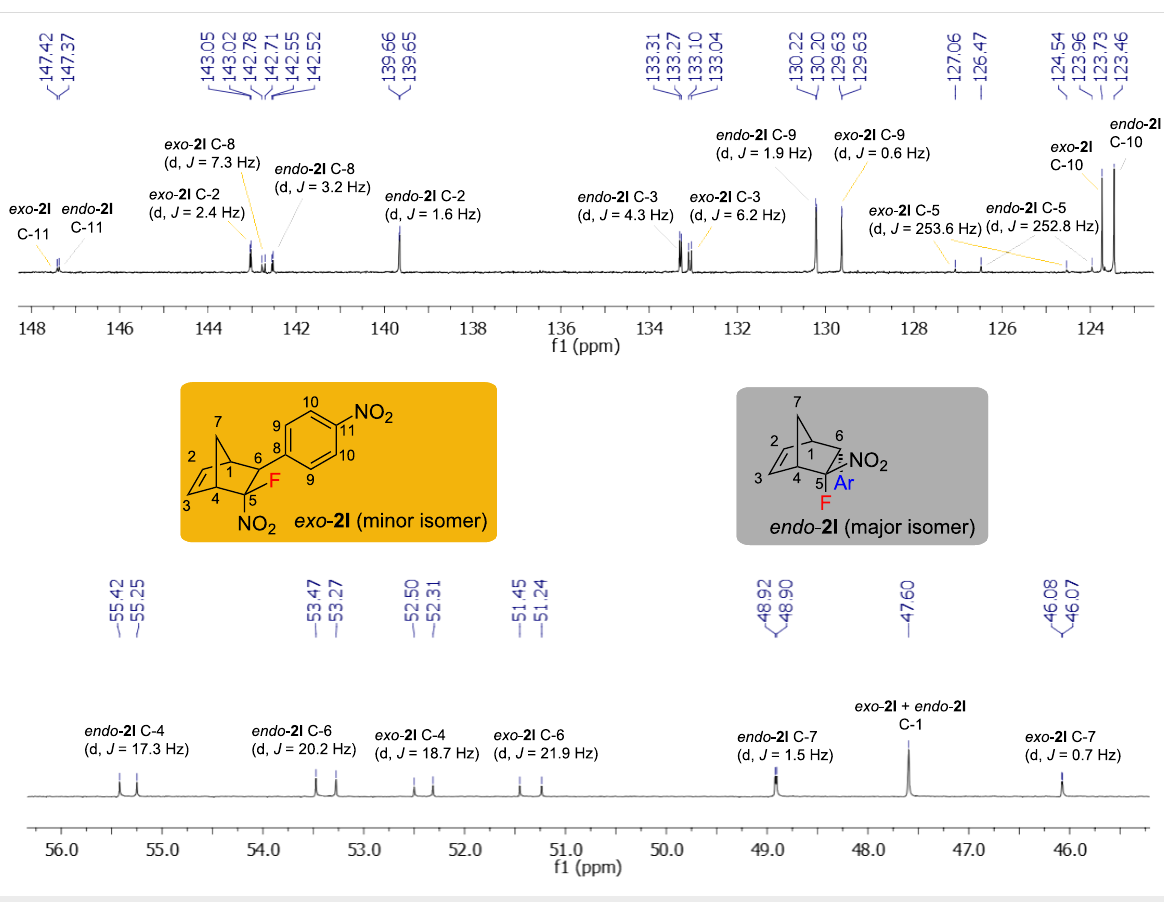
isomer). The same pattern in the chemical shifts and